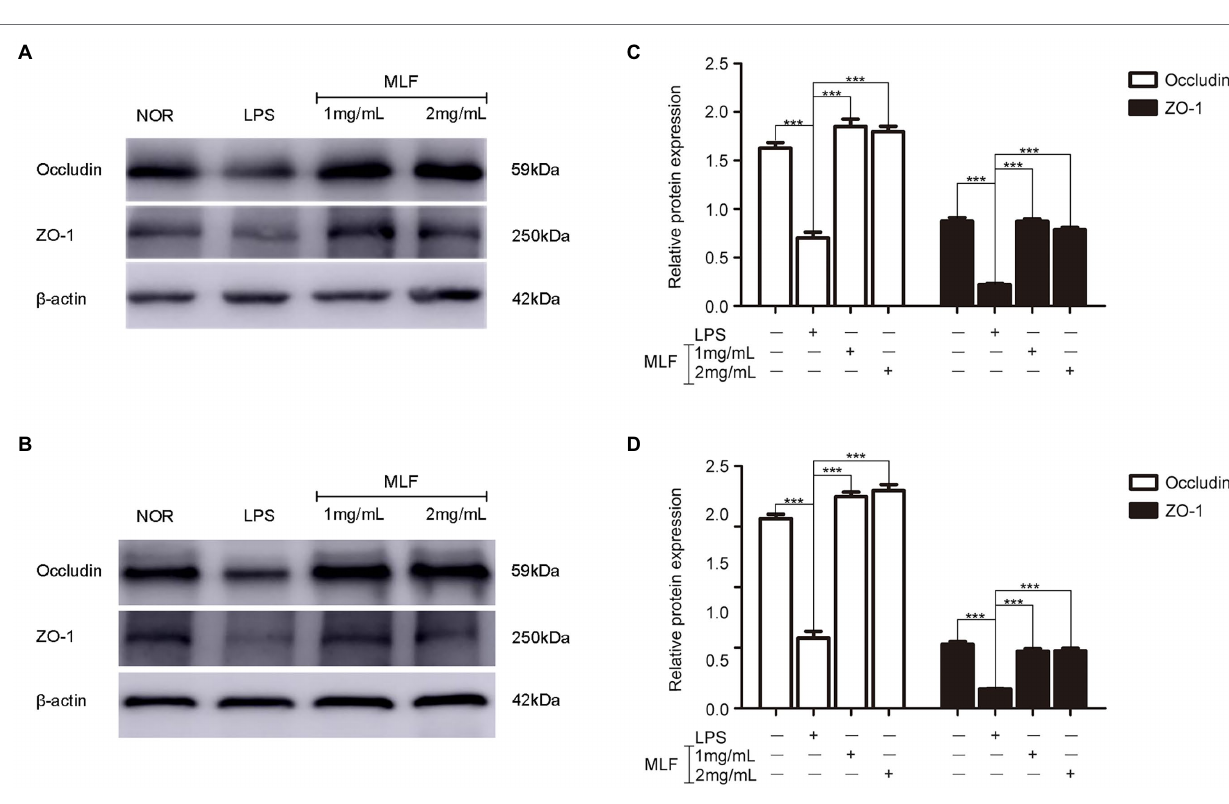
FIGURE 4 | The levels of Occludin and ZO-1 in caco-2 cells. Occludin and ZO-1 levels were examined in Caco-2 cells which were pretreated with 50 μ g/ml LPS for 12 h, then treated with MLF (1 and 2 mg/ml) for 24 h (A) or 48 h (B) . (C,D) quantification of Occludin and ZO-1. All groups were statistically analyzed with the LPS group. Data are expressed as means ± S.E. *** p <